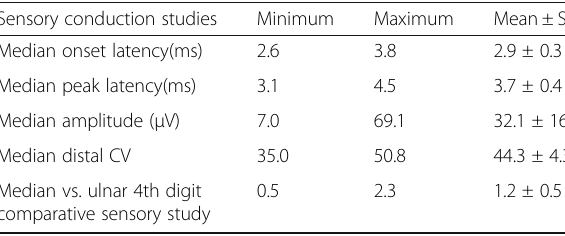
Table 1 Values of median sensory conduction studies of the patient group Sensory conduction